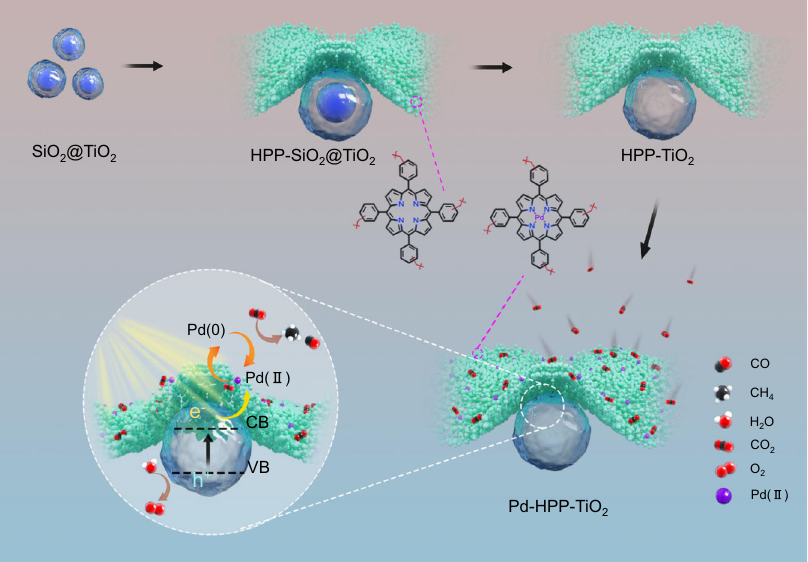
Fig. 1 Schematic illustrations. Synthesis of porous Pd-HPP-TiO 2 and the possible mechanism of photocatalytic CO 2 reduction. The chemical structures of HPP and Pd-HPP units are